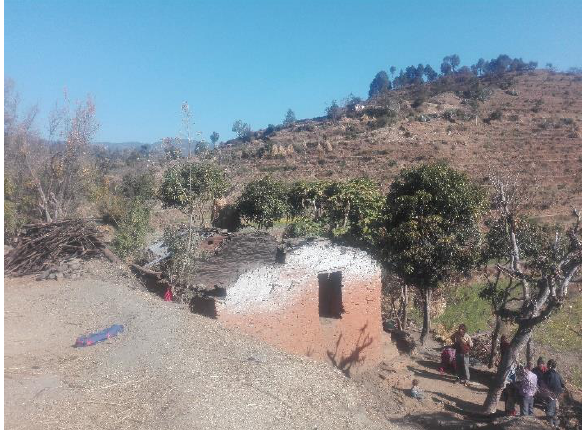
Figure 4. A selected house of a beneficiary of FABLRP in rural hills of Dadeldhura